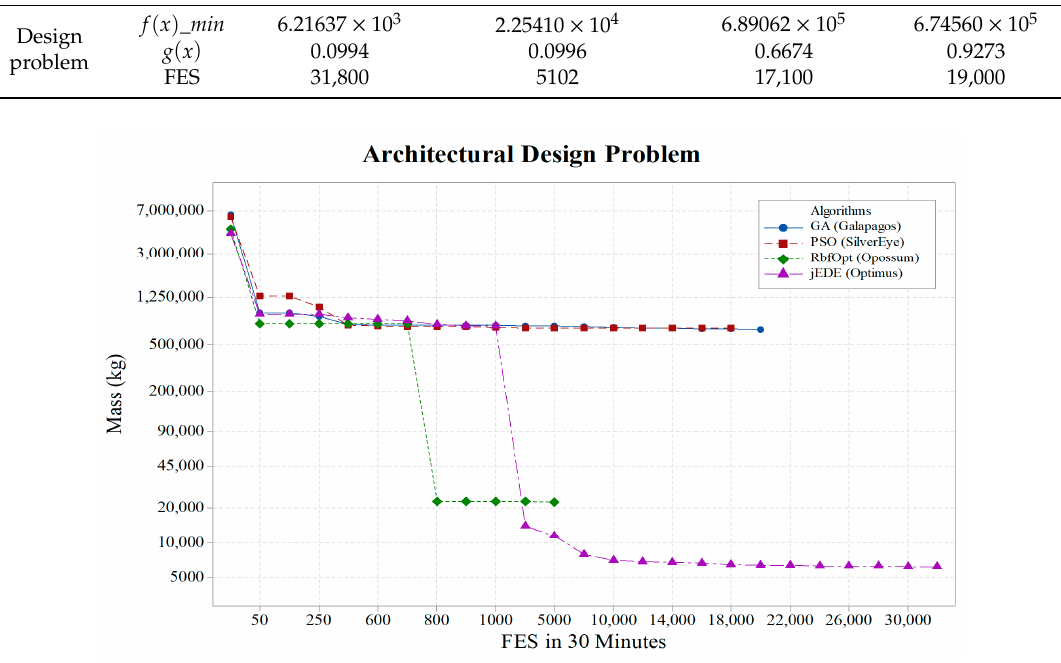
Figure 13. Convergence graph of architectural design problem.